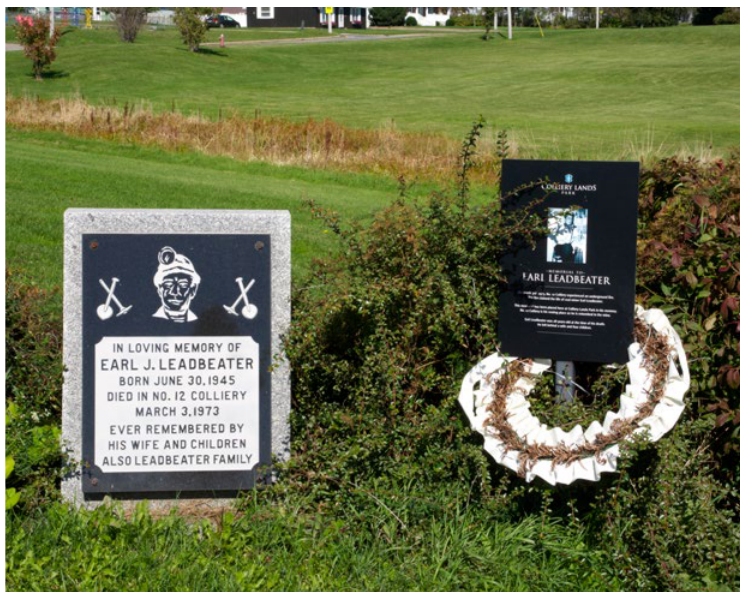
Figure 4. Leadbeater